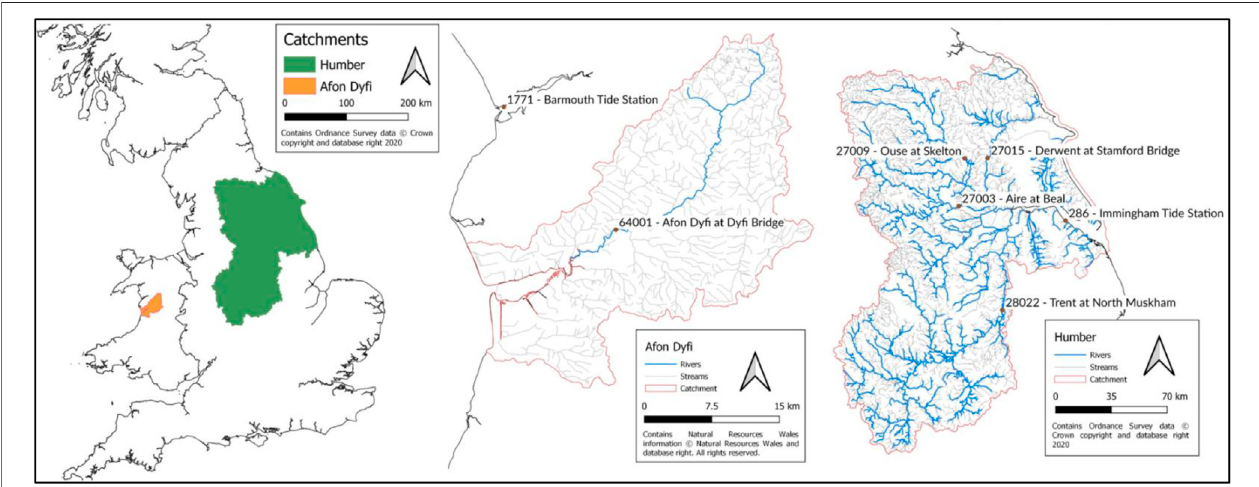
FIGURE 1 | Map of Britain showing the location of the Dy fi and Humber estuaries and their drainage basins. Fluvial and sea level gauge stations from which data was acquired are labeled.